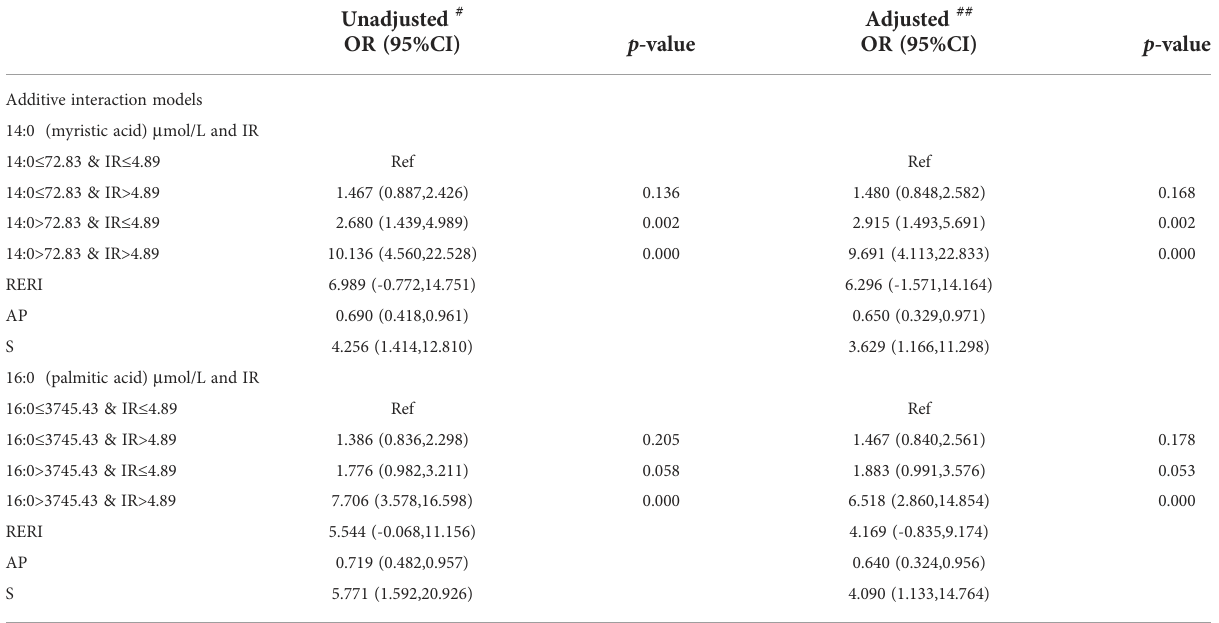
TABLE 3 Odds ratio of saturated fatty acids and additive interaction with insulin resistance for nonalcoholic fatty liver disease. Unadjusted #